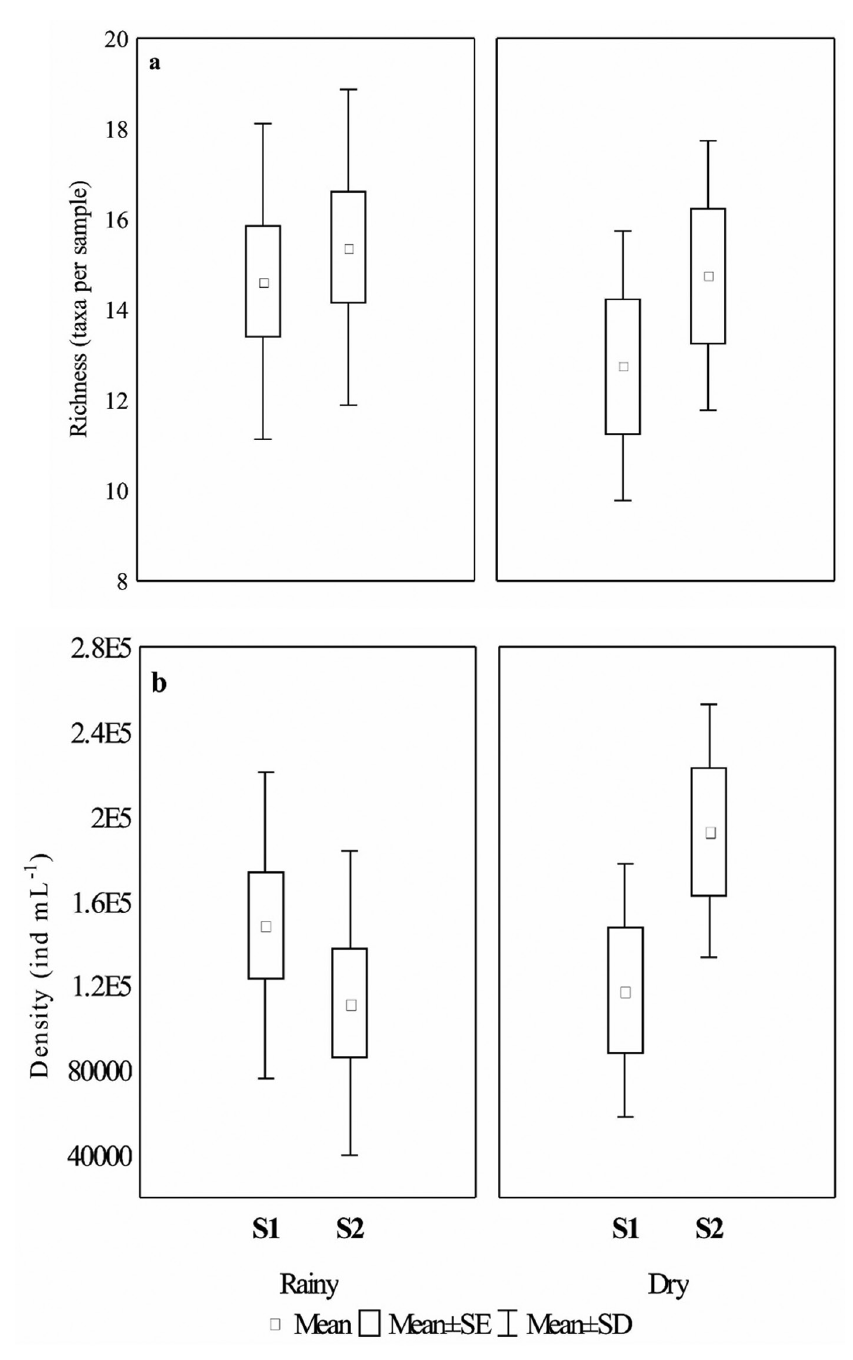
Figure 4. Mean values and standard deviation of the richness (a) and density (b) phytoplankton in stabilization